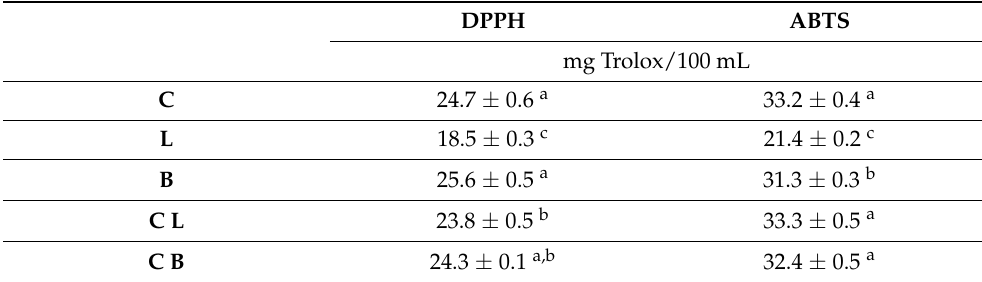
Table 2. Antioxidant activity measured by DPPH and ABTS methods (mean ± SD, n =